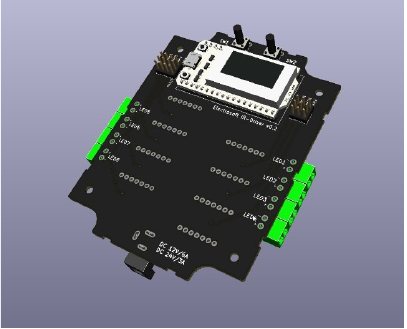
Figure 2. The 3D model of the control